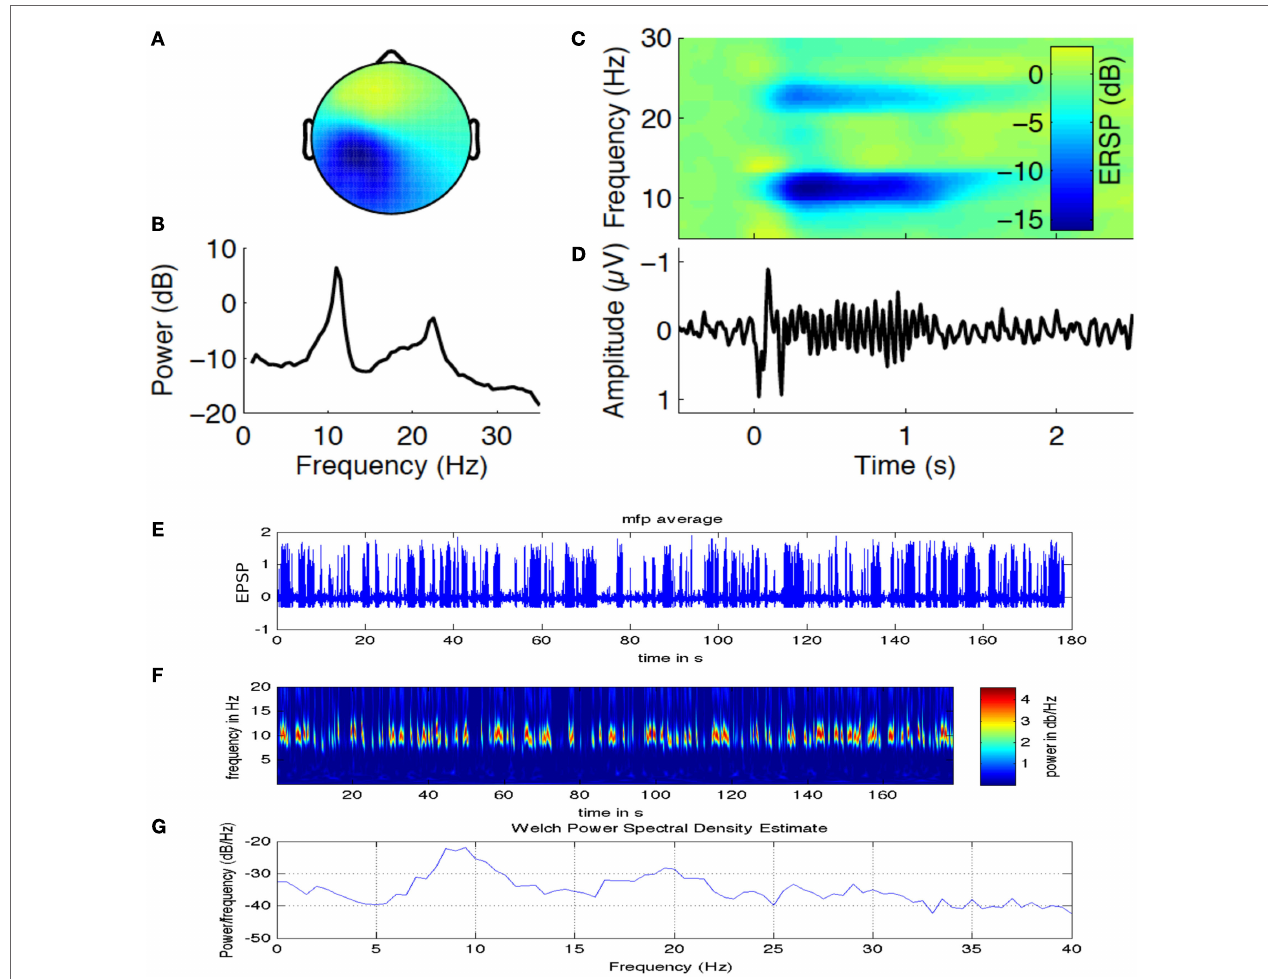
FiGUre 6 | alpha band oscillations and state dependent reorganization in the cortex . Figure adapted and modified from Sigala et al. (35). (a) Alpha and Beta band power in channels distributed over left somatosensory, motor cortex (contralateral side to the tactile stimulation side). (B) Two prominent power spectral peaks one at 10–12 Hz (central μ Alpha) and the other at 15–20 Hz (Beta band). (C) The evoked somatosensory response potential (ERSP) to repetitive stimulation where maximum powers in decibel are located in the two identified frequency bands. (d) Temporal dynamics of amplitude exhibit ERD followed by stimulation. (e) Simulated mean field EEG activity is shown for the somatosensory, motor cortex based on channel location map. (F) A representative example of Alpha band specific cortical activation. (G) Power spectral density estimate using Welch method to compare power spectral distribution from model against empirical power spectral distribution displayed in (B)